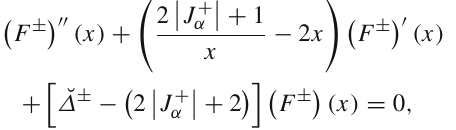
(cid:23) (cid:22) 2 ˘ ˘ Δ ± = / M ω and k ± (cid:2) (cid:3) s J ± α ± 1 , the energies